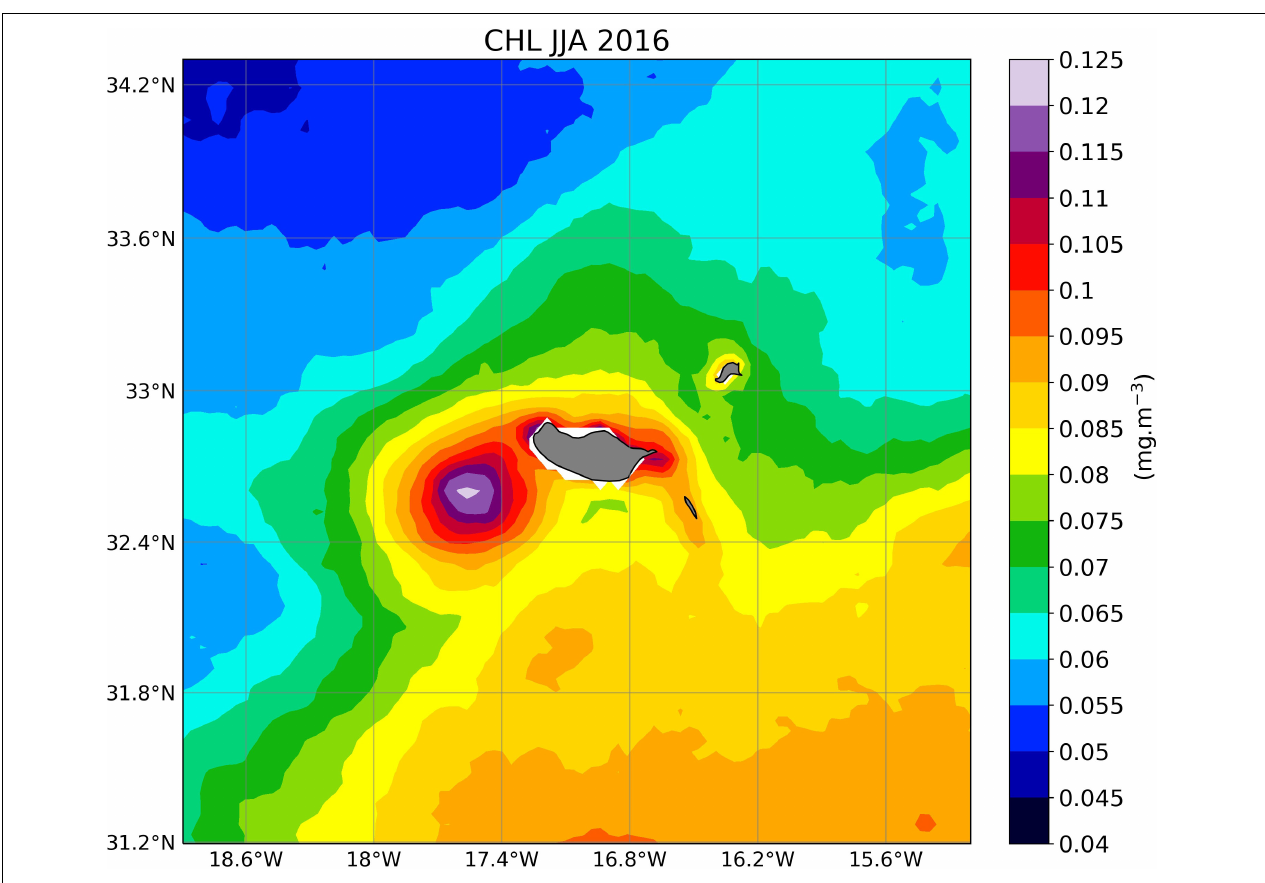
FIGURE 8 | Mean 2016 summer (JJA) remote detected chlorophyll concentration, nearby Madeira, with 4 km resolution, based on the merging of the sensors SeaWiFS, MODIS, MERIS, VIIRS-SNPP&JPSS1, and OLCI-S3A&S3B.